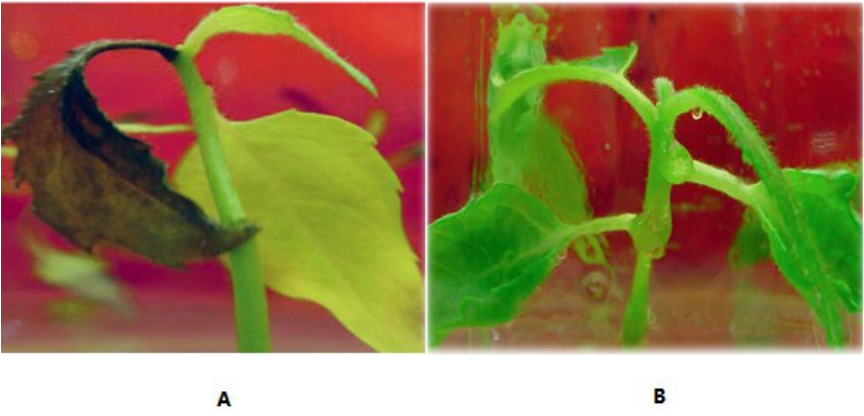
Figure 5. Explants planted in medium containing 0.5% NaCl for 35 days. The non-transgenic explants ( A ) began to turn yellow, while the transgenic explants ( B ) remained